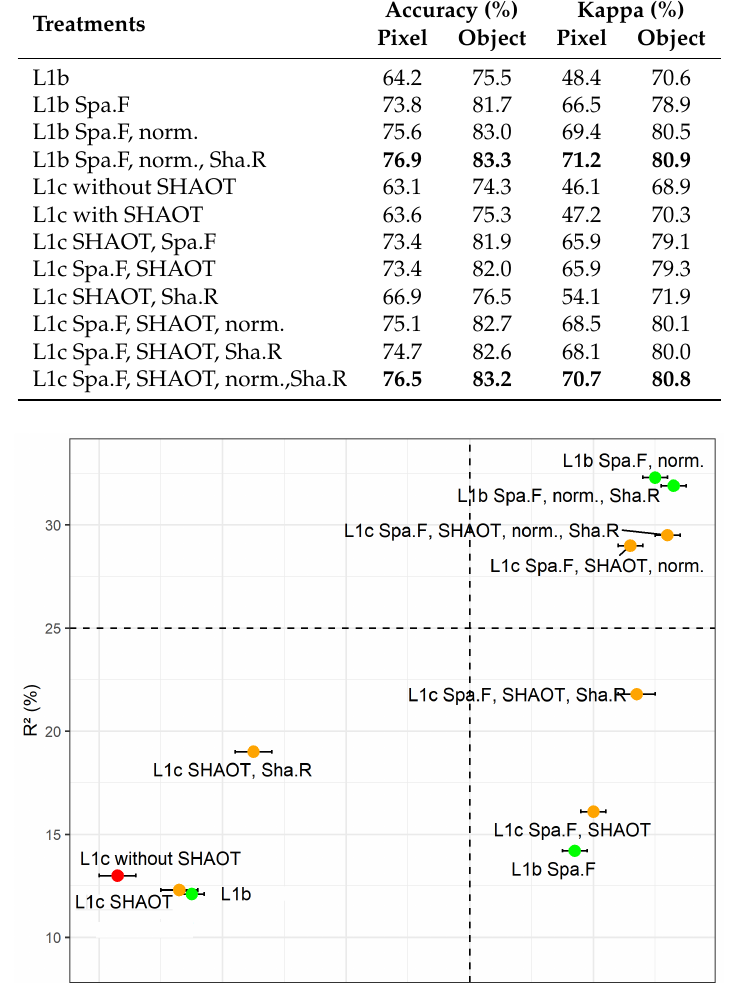
Table 4. Summary of mean accuracies and kappa results from data acquired on 19 September using the 20 most abundant species. The highest scores are highlighted in bold.